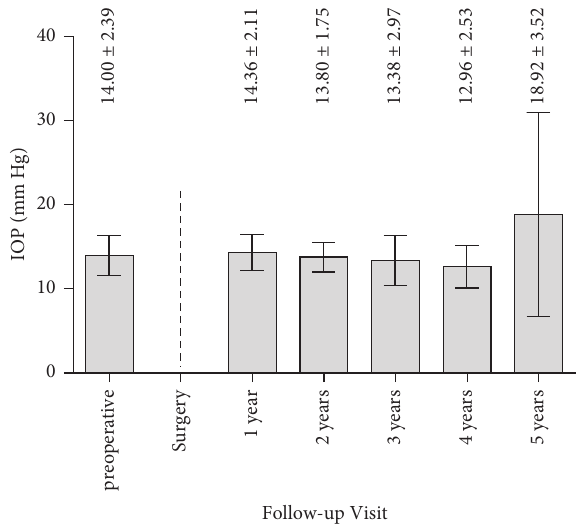
Figure 4: IOP pre- and up to 5 years Table 1: Results of patient questionnaire.